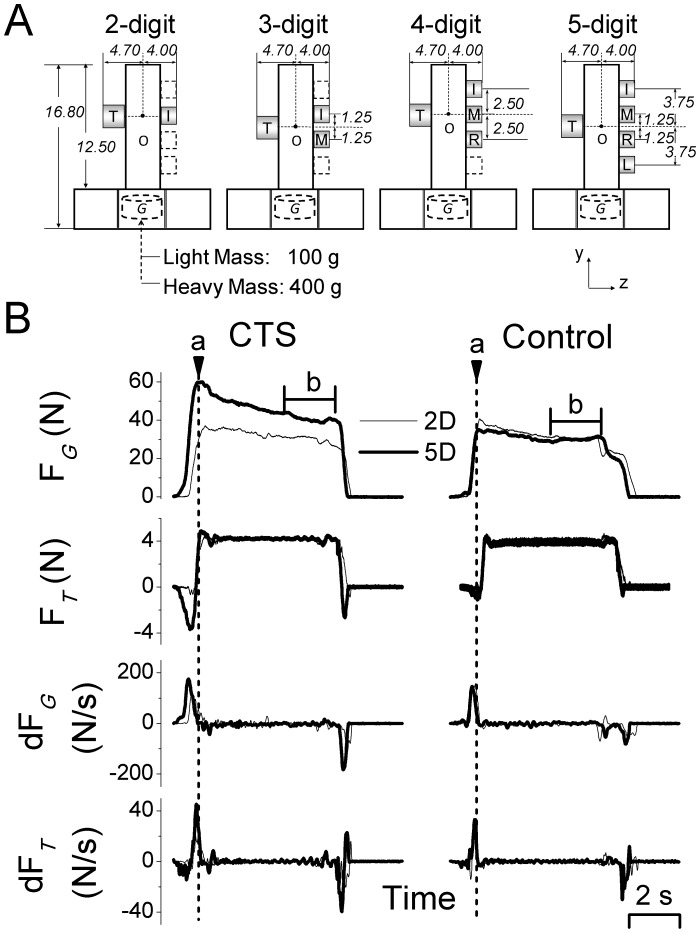
Grip device and experimental variables.Panel A shows the front view of the grip device used for each grip type condition. All dimensions shown are in cm. Force/torque (F/T) sensors are mounted on both sides of the device to measure forces and moment of forces exerted by each digit involved in a given grip type condition (thumb, index, middle, ring, and little fingers: T, I, M, R, and L, respectively). A mass (“G”; 100 g or 400 g) was inserted in the midpoint at the bottom of the grip device (“Light mass” and “Heavy mass”, respectively). For the 2- and 4-digit grip types, the center of the thumb sensor was collinear with the center of the index or middle finger sensor, respectively. For the 3- and 5-digit grip types, the center of the thumb sensor was collinear with the mid-point between the centers of the index and middle finger or middle and ring finger sensors, respectively. Note that for each grip type, all five sensors were mounted on the grip device to maintain a constant mass for a given mass condition, thus changes in grip types were implemented by changing the relative position of F/T sensors. A magnetic tracker (not shown) was used to track the object position and orientation of the object during the manipulation. ‘O’ denotes the point about which moments were computed (see Methods for more details). Panel B shows, from top to bottom, the time course of the sum of all digit grip forces (FG), the sum of all digit tangential forces (FT), and the derivatives of FG and FT. Data are aligned with object lift onset (vertical dashed line, a). Note that analysis of digit forces during object hold was performed on data averaged over the last 2 seconds of the hold (horizontal bar, b). Data are from one representative CTS patient (S3) and her matched control (left and right column, respectively) performing the task on the seventh trial for the “light mass” condition and two grip types (two- and five-digit, 2D and 5D, respectively).